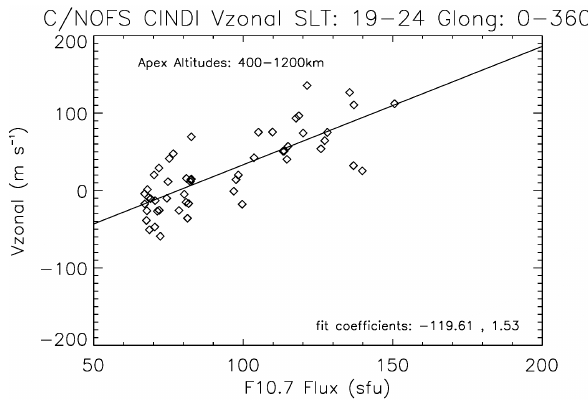
455 Figure 7. Monthly averaged zonal drifts (diamonds) versus monthly averaged F10.7 456 flux for August 2008–December 2012. CINDI IVM data in the 19–24 SLT range, all 457 Fig. 7. Monthly averaged zonal drifts (diamonds) versus monthly longitudes, and the 400–1200 km apex altitude range was used. The least-­‐squares fit 458 averaged F10.7 flux for August 2008–December 2012. CINDI IVM straight line is shown and the fit coefficients are indicated at the bottom right. See 459 text for details. 460 data in the 19:00–24:00SLT range, all longitudes, and the 400– 461 1200km apex altitude range were used. The least-squares fit straight 462 line is shown, and the fit coefficients are indicated at the bottom right. See text for details.